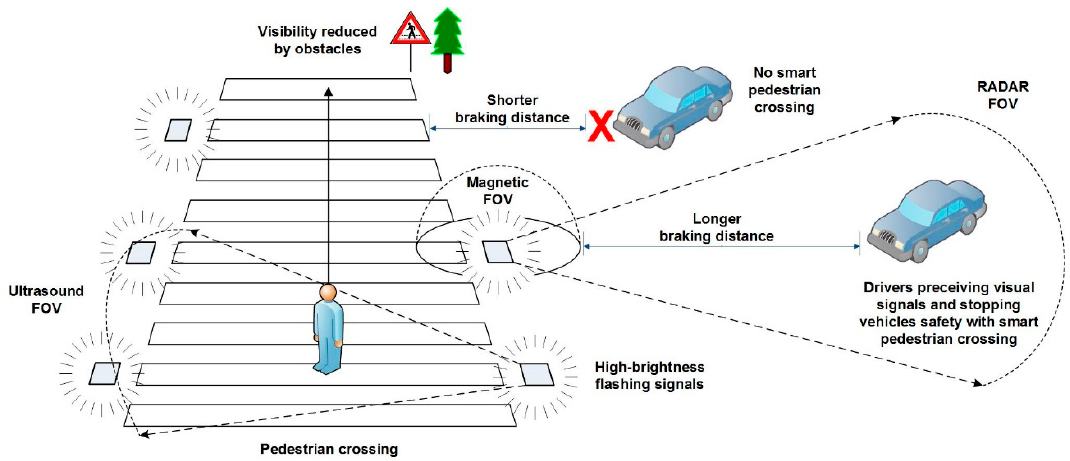
Figure 1. General description of the system and field of view for each sensor.